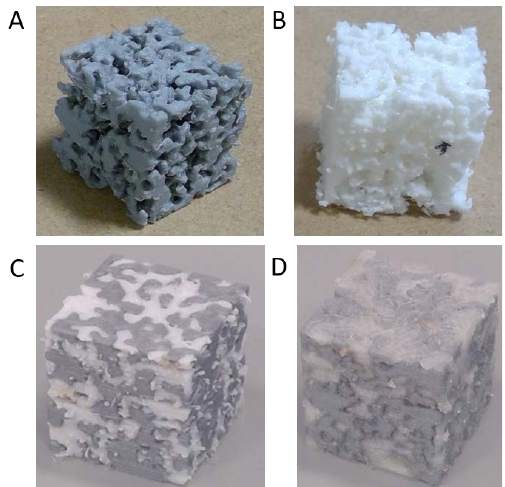
Figure 4. Cube specimens (side of approx. 30 mm) ( A ) 3D printed porous PLA specimen, ( B ) 3D printed porous TPU specimen, ( C ) 3D printed PLA and TPU specimen, ( D ) 3D printed PLA and Nylon